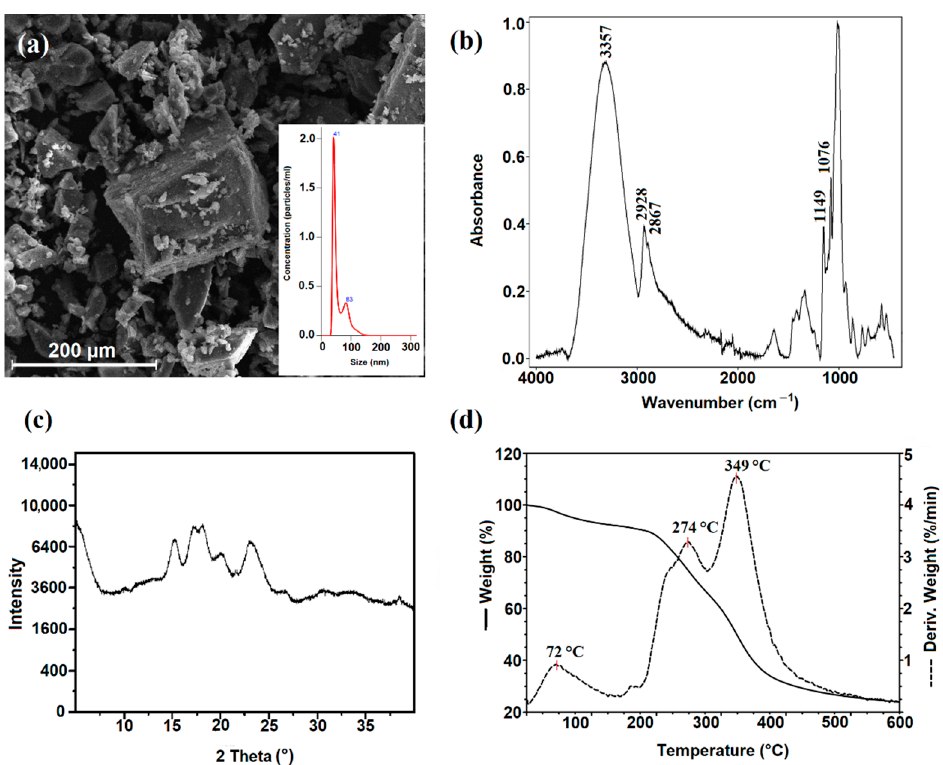
Figure 2. ( a ) SEM image, with inset showing the size distributions and particle concentrations of starch nanocrystals; ( b ) ATR-FTIR spectra; ( c ) X-ray diffraction (XRD) patterns; and ( d ) TGA-DTG curves of starch nanocrystals.